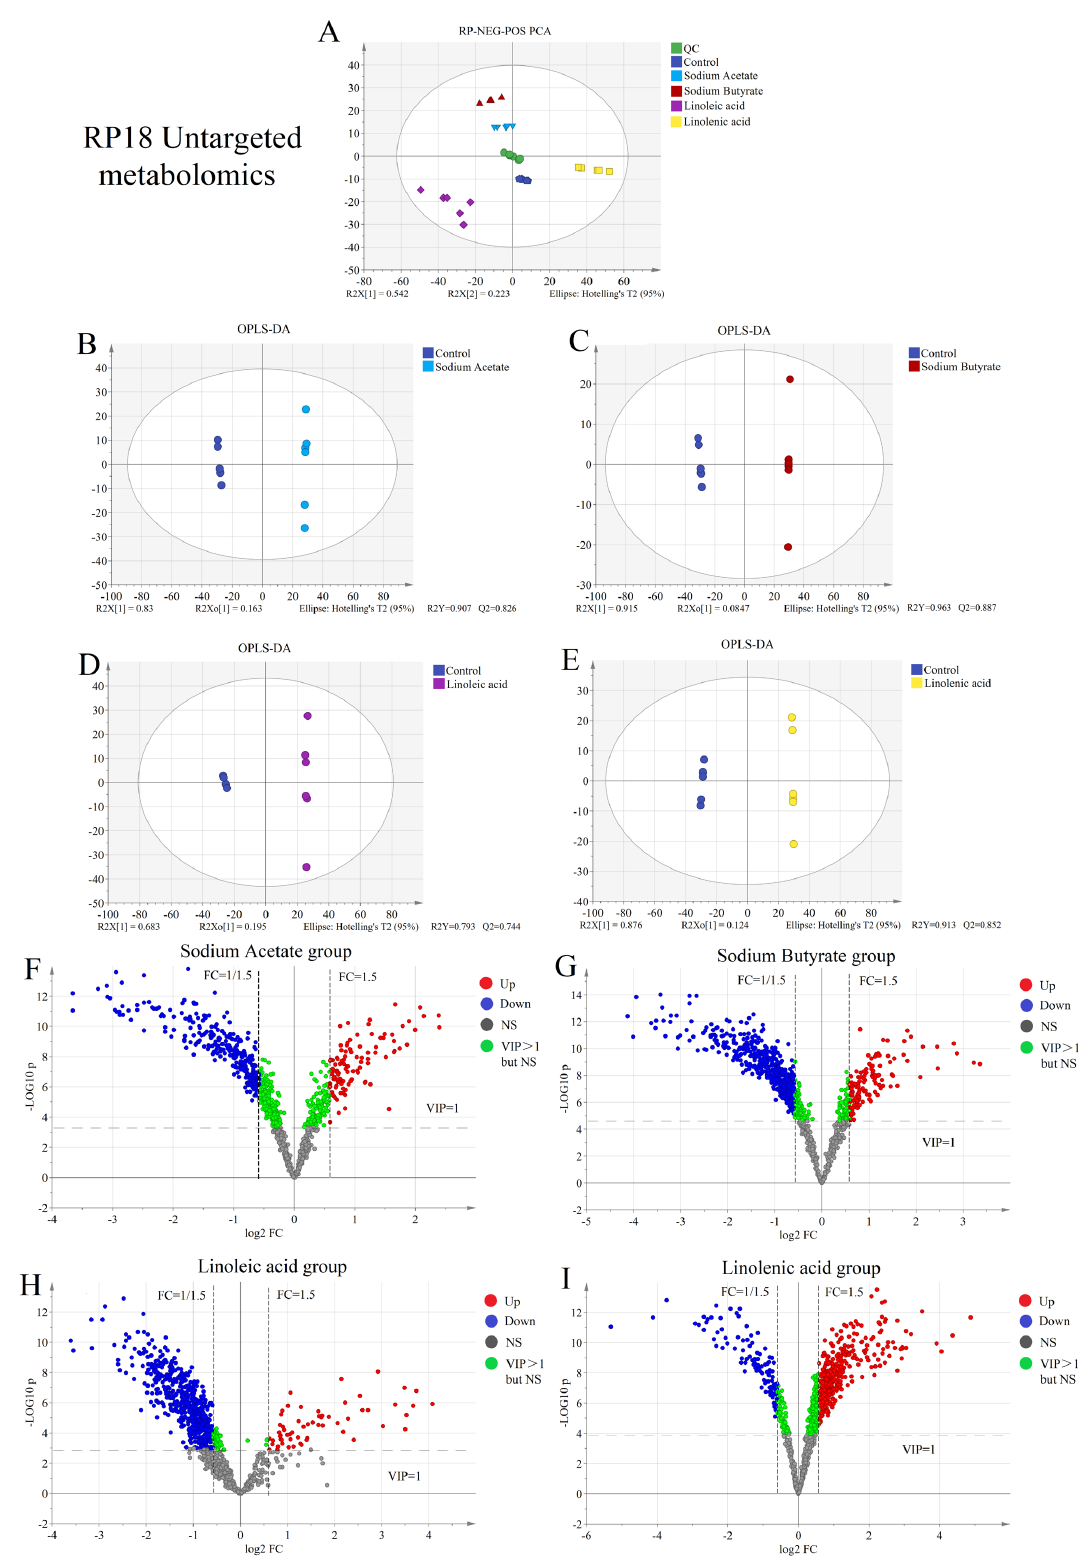
Figure 2. Screening differential metabolites between the control group and four fatty acid groups based on RP18 untargeted metabonomics: ( A ) PCA plots; ( B – E ) OPLS-DA plots; ( F – I ) volcano plots of sodium acetate group, sodium butyrate group, linoleic acid group, and linolenic acid group compared with the control